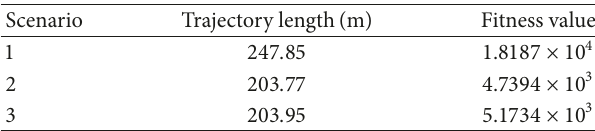
Table 7: Comparison results of trajectory length and fitness